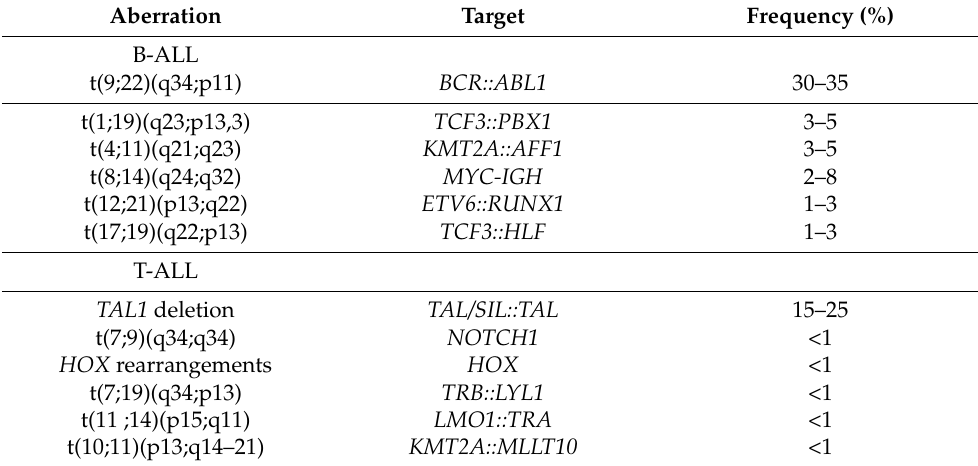
Table 1. Commonest chromosomal aberrations in adult